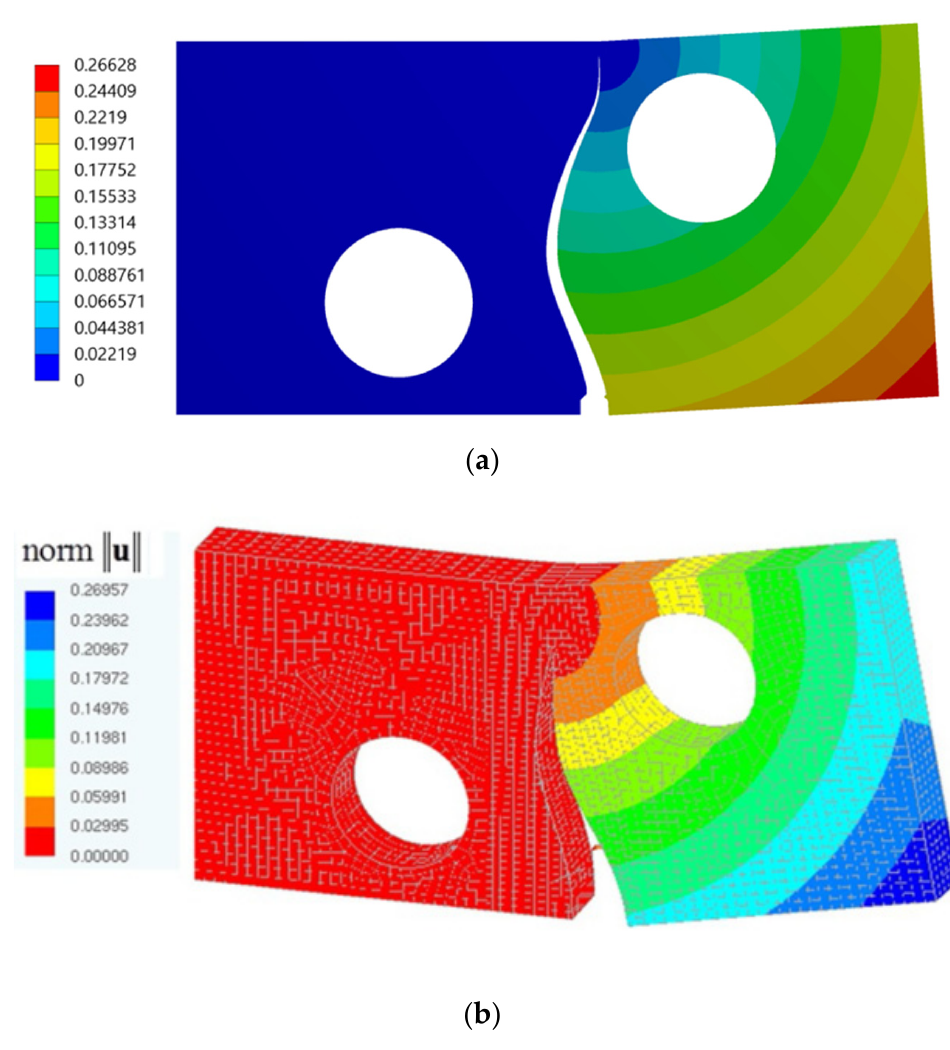
Figure 9. Total deformation of the last step of crack propagation ( a ) present study, ( b ) DBEM by [44].